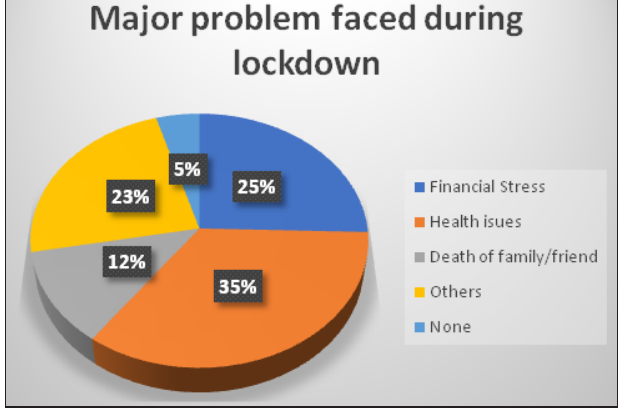
Figure-1V:Effectiveness of Online Learning in comparison to face to face in campus